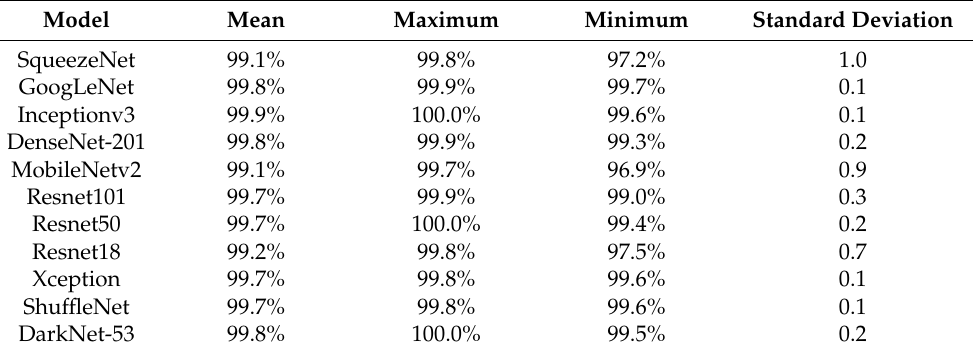
Figure 2. Examples of the confusion matrices for GoogLeNet and SqueezeNet models using 60% of the data for training. Table 3. The mean, minimum, maximum, and standard deviation of the accuracy taken over 10 runs and using 60% of the data for